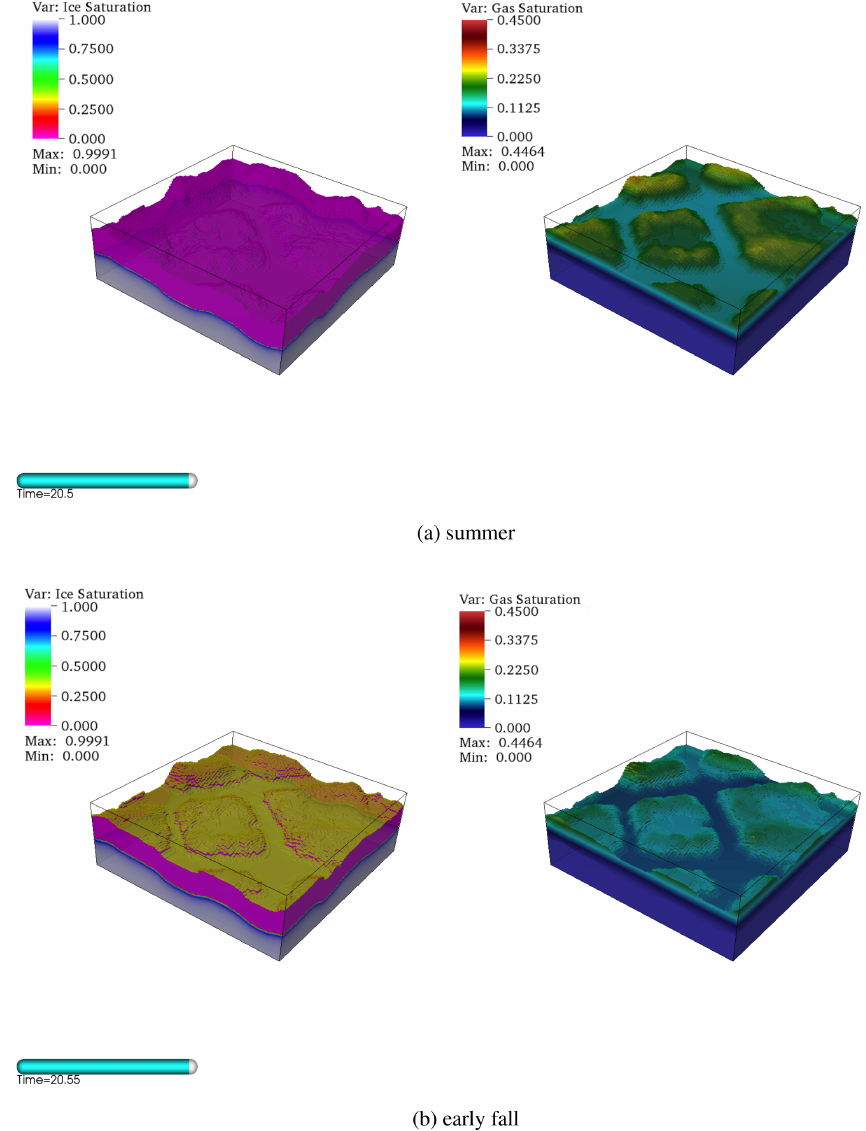
Figure 9. Ice thawing and freezing with seasonal surface temperature variation (continued). Ice and gas saturations for summer and early fall shown here. For the values of parameters used see Fig.